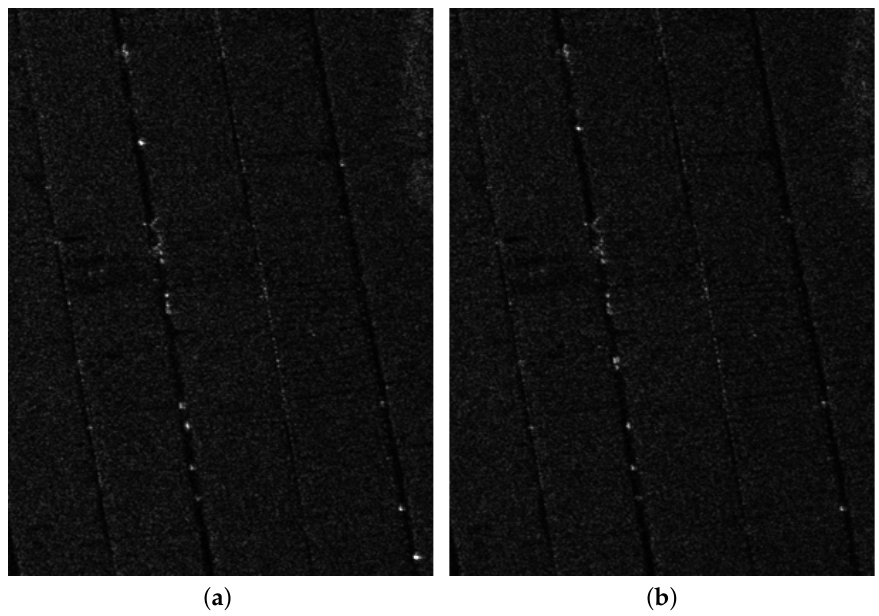
Figure 7. The C-band SAR images of the experimental scene. ( a ) Reference SAR image. ( b ) Mission SAR